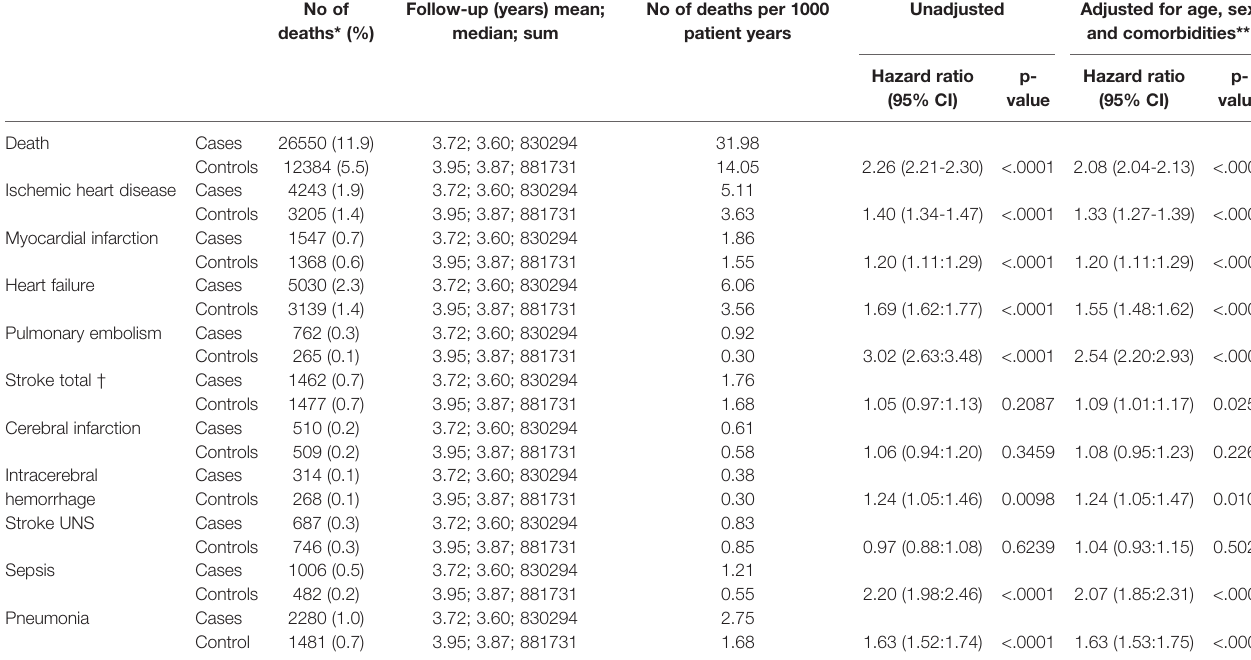
TABLE 3 | All-cause mortality and disease-speci fi c mortality in GC users compared to age- and sex-matched controls.